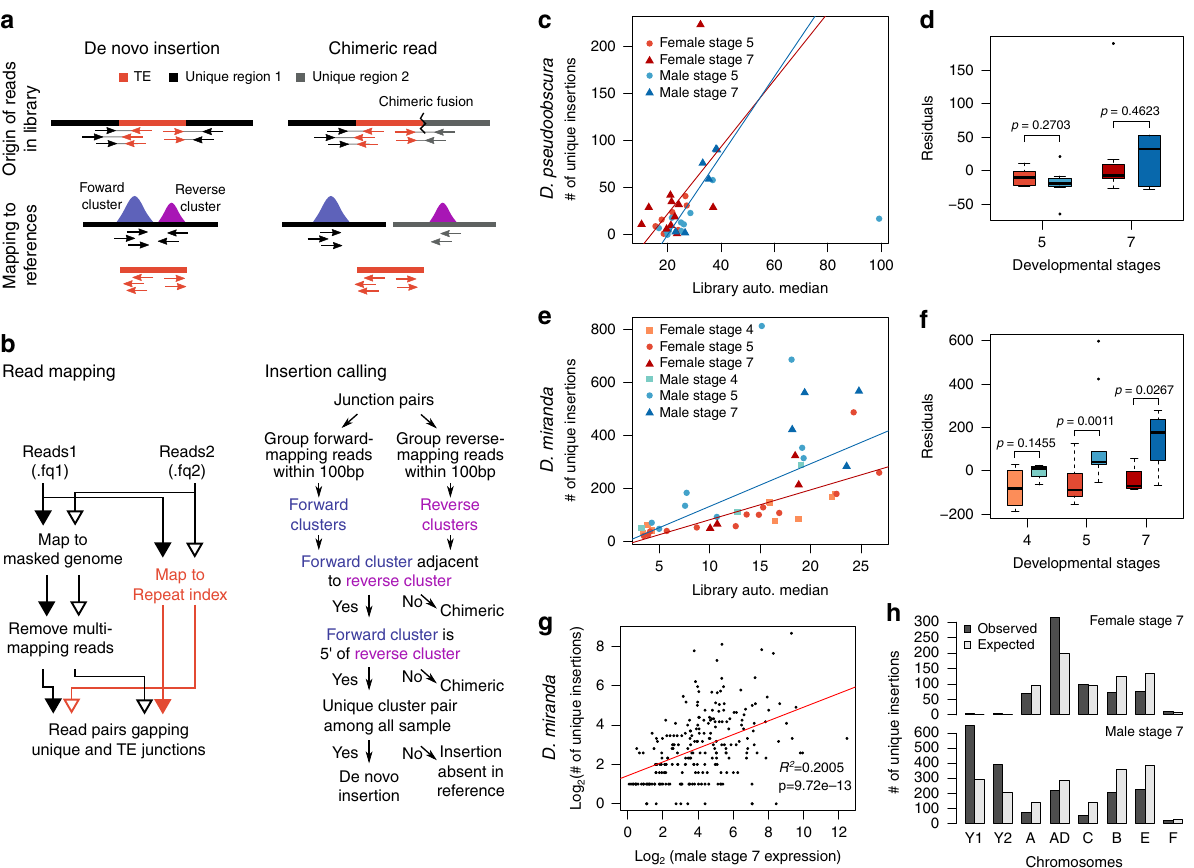
Fig. 5 D. miranda males show more de novo TE insertions than females. a Schematic diagram of rationale behind TE insertion identi fi cation. b Computational pipeline implementing the strategy in a . The left panel outlines the mapping strategy to identify mate pairs at insertion junctions. The right panel outlines the fi ltering strategy to identify de novo TE insertions. See Supplementary Data 3 for summary of insertions fi ltered and identi fi ed for each library. c The numbers of de novo TE insertions identi fi ed in D. pseudooboscura embryos are plotted against the autosomal median coverages. Lines of best fi t are shown for the male (blues) and female (reds) samples, separately. d The effect of library size is removed by regression of TE insertion numbers against library coverage and taking the residuals. Boxplot depicts the residuals of the regression binned by sex and developmental stages. P values are labeled above the comparisons (two-tailed Wilcoxon rank-sum test, no multiple testing correction). In the boxplots, whiskers delineate the minima and maxima of the distributions, the box delineates the 25th and 75th percentiles, and the centers mark the medians. e , f Same as c and d , but for D. miranda embryos. g The number of de novo insertions across all male D. miranda stage 7 embryos is plotted against the transcript abundance. Line of best fi t is in red and R 2 of the regression and the signi fi cance of the correlation are shown. Only TEs with de novo insertions are plotted. h The observed and expected distribution of insertions across the chromosomes are depicted in females (top) and males (bottom). Source data are provided as a Source data fi